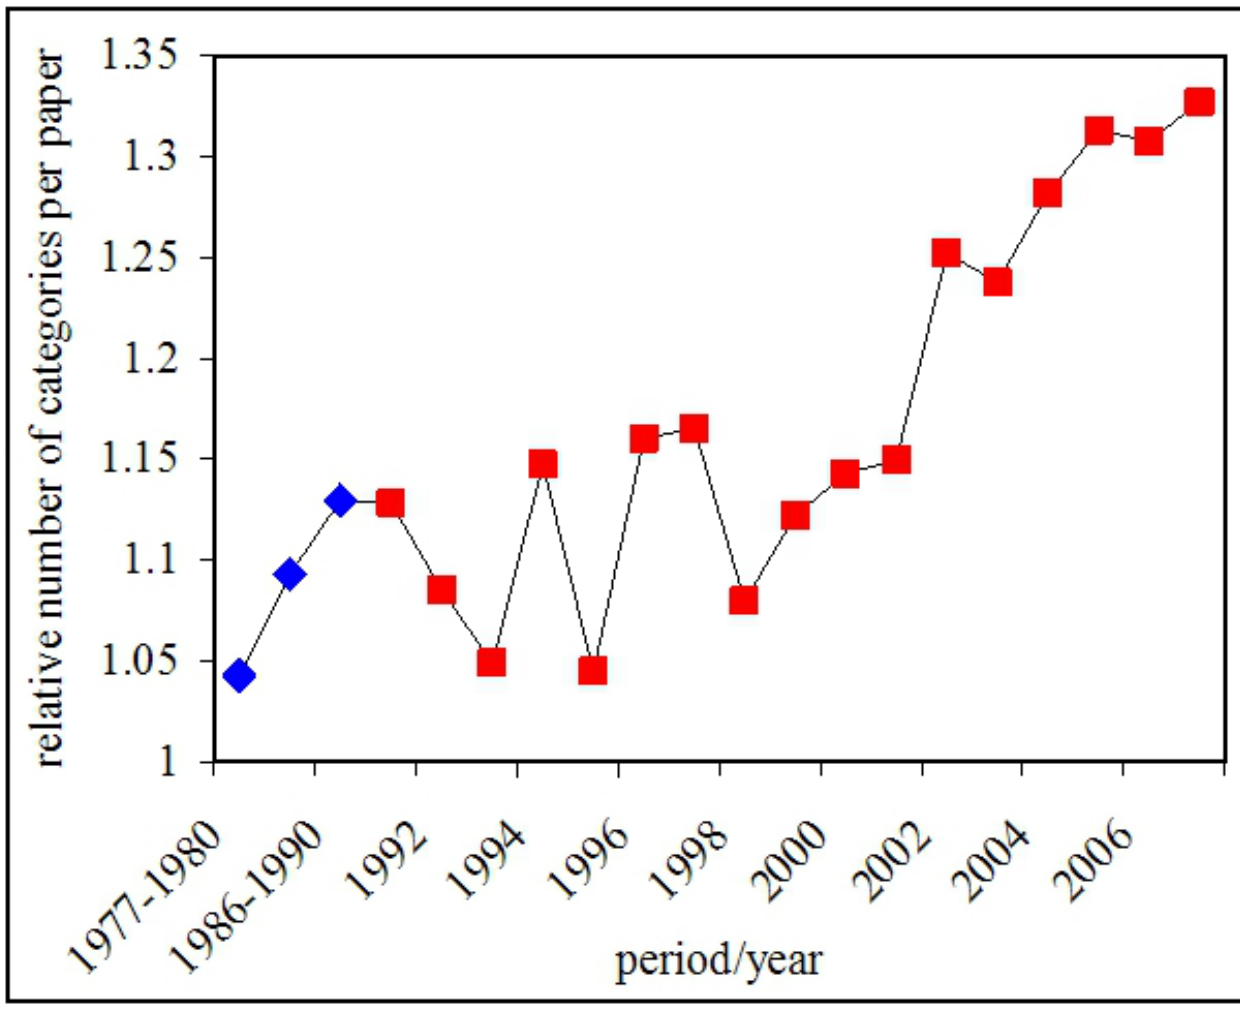
Fig. 7. The average number of knowledge domains that publications issued in one year or period belong to. For earlier years, 5-year periods are used as only small numbers of publications are